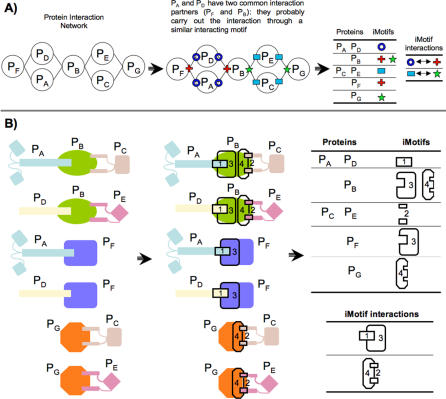
Definition of an Interacting Motif (iMotif)The definition of an iMotif depends on the minimum number of common partners required in order to consider the given binary protein interactions mediated through a common interacting motif.(A) From the protein interaction network perspective, proteins with common partners (two in the example provided) are considered to interact with these partners through a similar feature, and, therefore, are classified as being of the same iMotif.(B) The same process is shown from a structural perspective: proteins interacting through a similar feature (regardless of the feature being two structural domains or a single binding site) are considered to have a common iMotif. To further illustrate the method, we also describe a sample iMotif assignment for prothrombin (UniProt code THRB_HUMAN) (Figure S3).